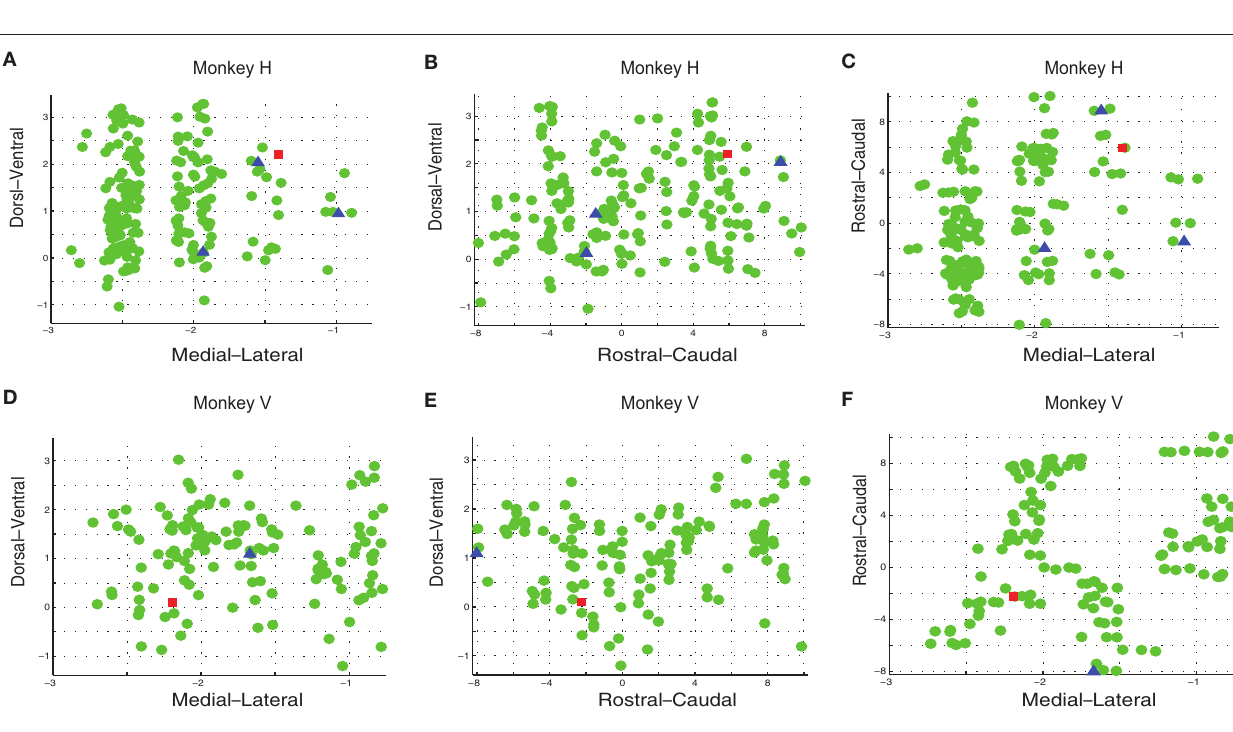
FigUre A4 | Distribution of K-means method around cue onset showed almost homogenous appearance. Unlike the K-means analysis around torque onset, the signal range that was taken was [ − 200, 500] ms around torque onset. Other parameters remained the